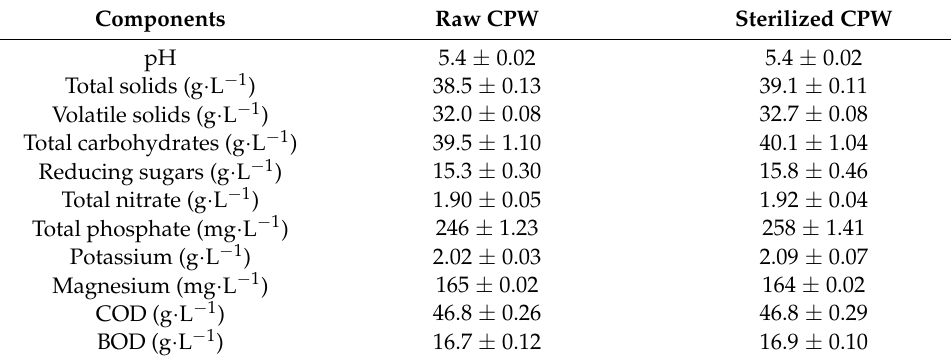
Table 3. Composition of CPW used in this